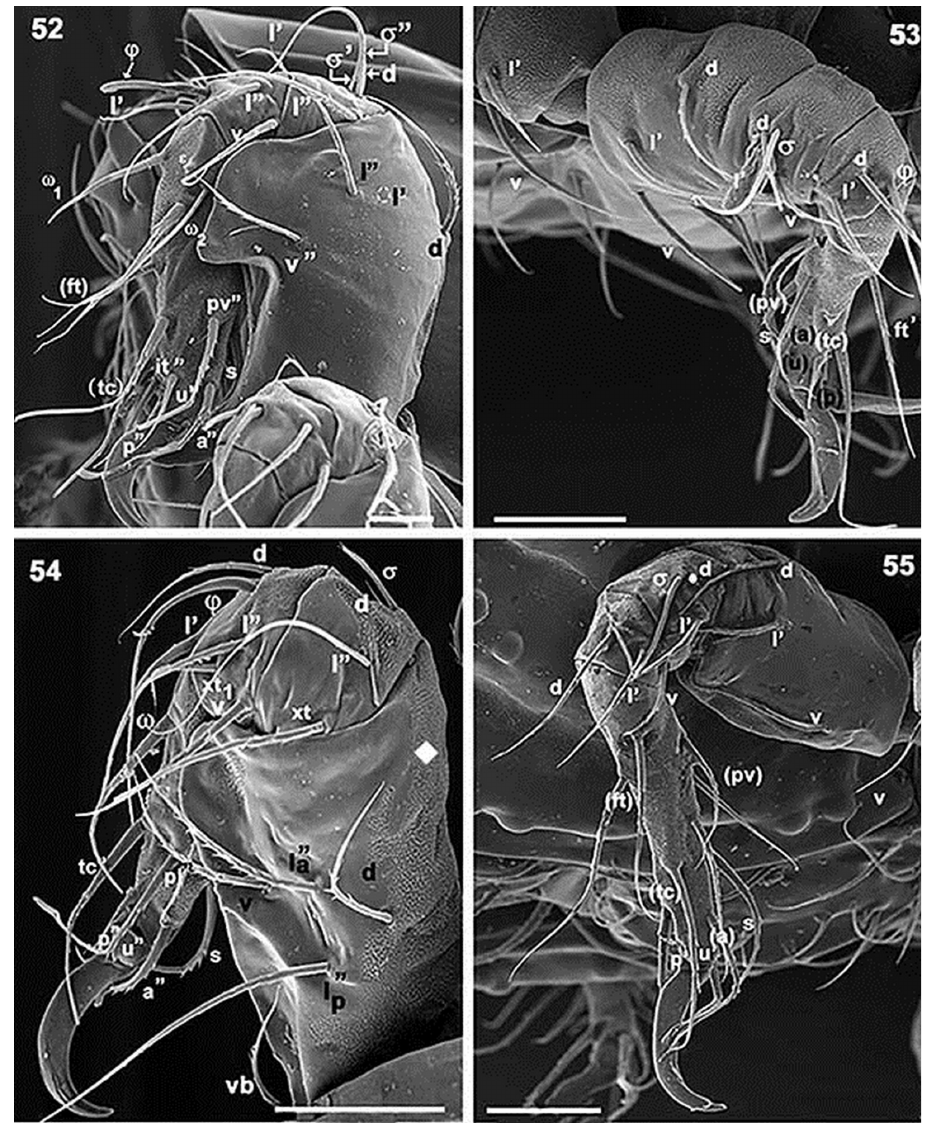
Figures 52–55. Paulianacarus costaricensis sp. n. Adult with cerotegumental layer. SEM. 52 leg I, antiaxial 53 leg III, antiaxial 54 leg II, antiaxial 55 leg IV, antiaxial. Abbreviations: See Material and methods. Scale bars: 52 = 20 μm; 53 = 50 μm; 54 = 50 μm; 55 = 50